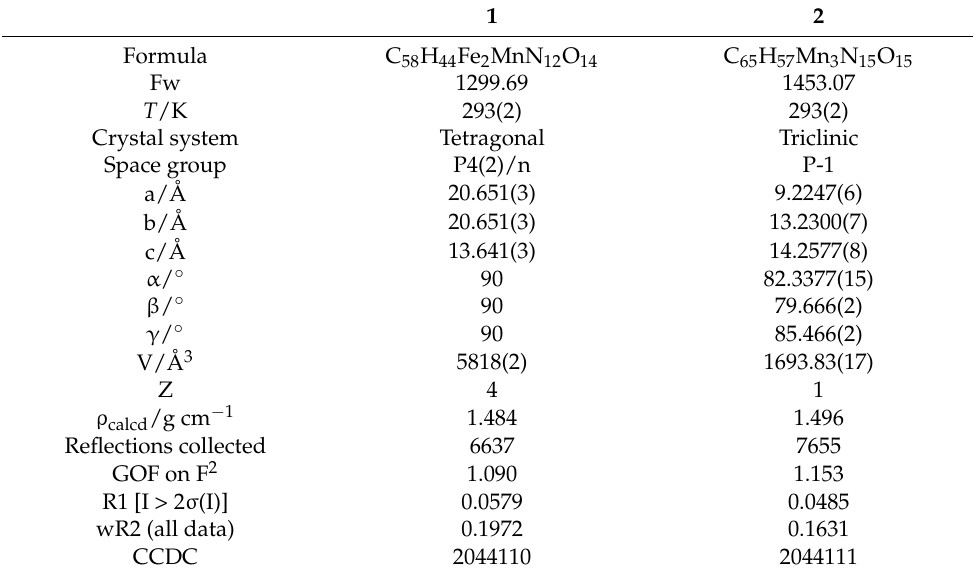
Table 1. Crystallographic parameters of complexes 1–2.